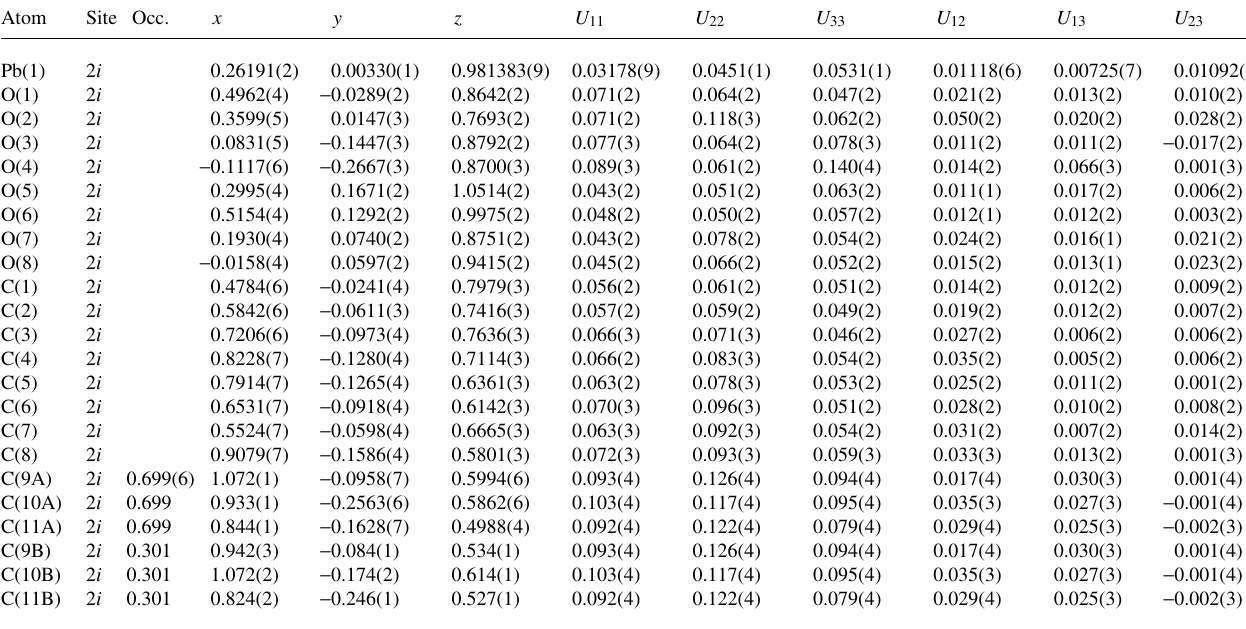
Table 3. Atomic coordinates and displacement parameters (in Å 2 )